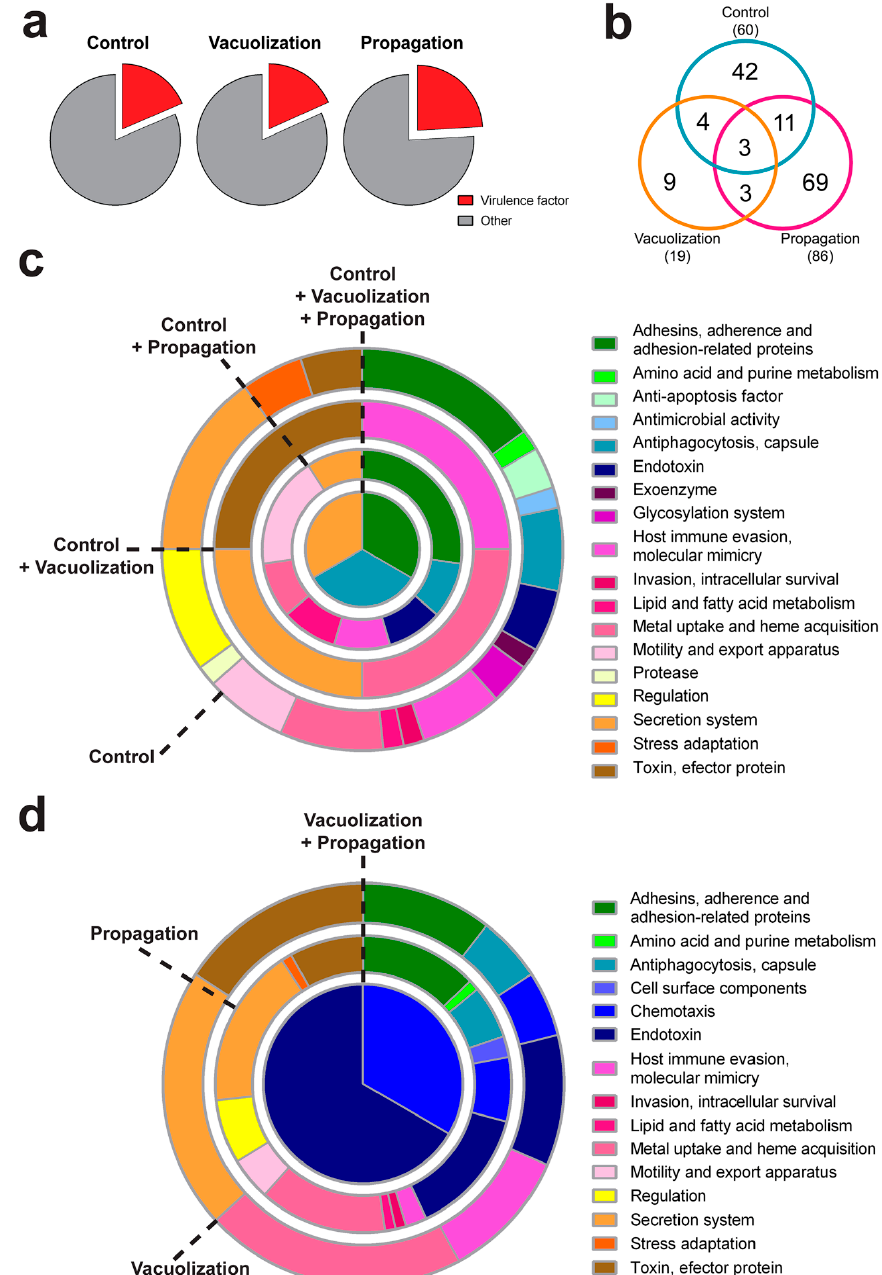
Figure 6. Virulence factors families identified by quantitative proteomics in P. salmonis proteomes from control sample, and infection samples in SHK-1 cells (vacuolization and propagation stages of infection). Proteins were classified according to the virulence factor data base (VFDB) family classification. ( a ) Pie charts of the proteins classified as virulence factors (red) in each P. salmonis proteome. ( b ) Venn diagrams showing the quantity of virulence factors identified in and shared between the three P. salmonis proteomes. ( c ) Virulence factor classification of P. salmonis proteins identified in the control, in control and vacuolization, in control and propagation, and in all three samples. ( d ) Virulence factor classification of P. salmonis proteins identified only in the infection